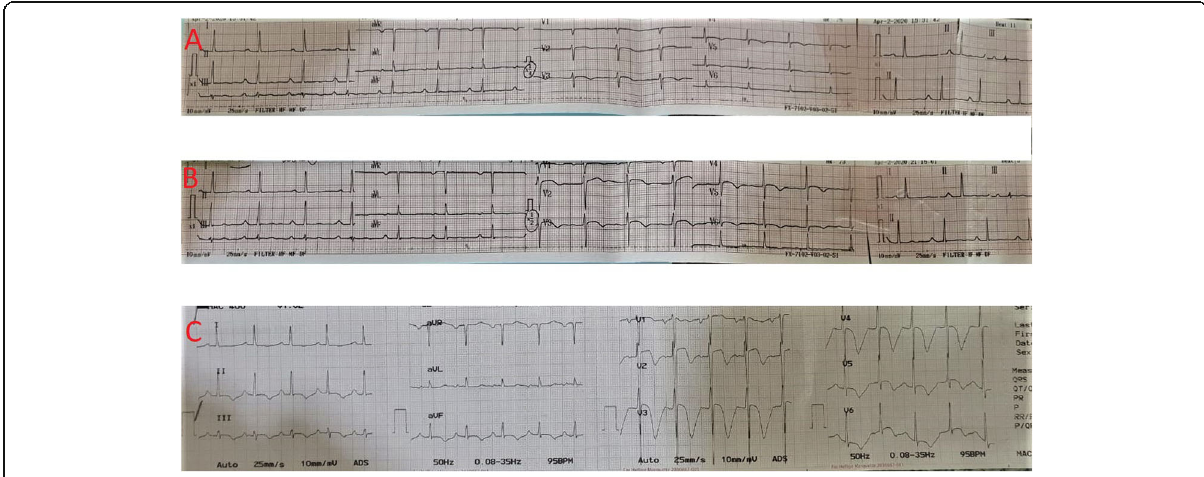
Fig. 1 Electrocardiography evaluation ( a ) performed on admission in the emergency room during pain period showed non-specific ST-T changes in lead V2-V5, ( b ) performed on the painless period after sublingual nitrate showed biphasic T waves inversions and minimally elevated ST segment in lead V2 and V3, ( c ) performed before transferred to hospital ward during the painless period showed deeply inverted T waves in leads